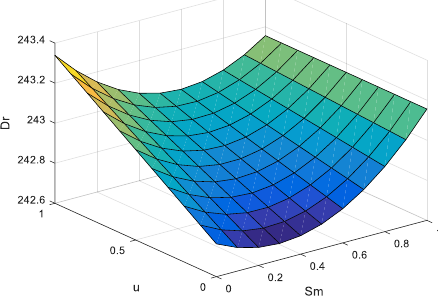
Figure 5. Effect of s m and µ on D r .